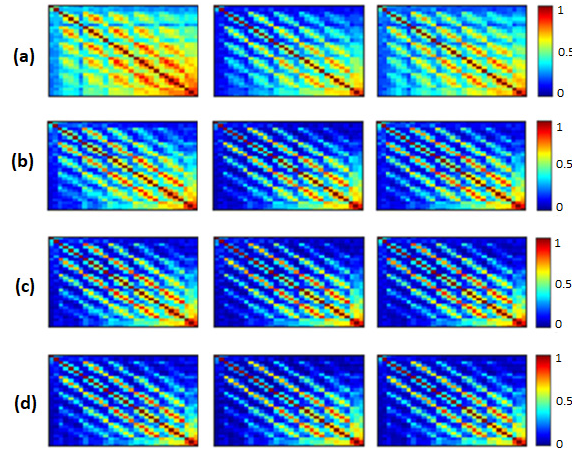
Figure 2. The average MSC across subjects in the SCI (left), MCI (middle) and AD (right) groups for the ( a ) delta, ( b ) theta, ( c ) alpha and ( d ) beta bands. The 30 electrodes are shown from left to right side, anterior-posteriorly (up to bottom). The color bar indicates the values of MSC.